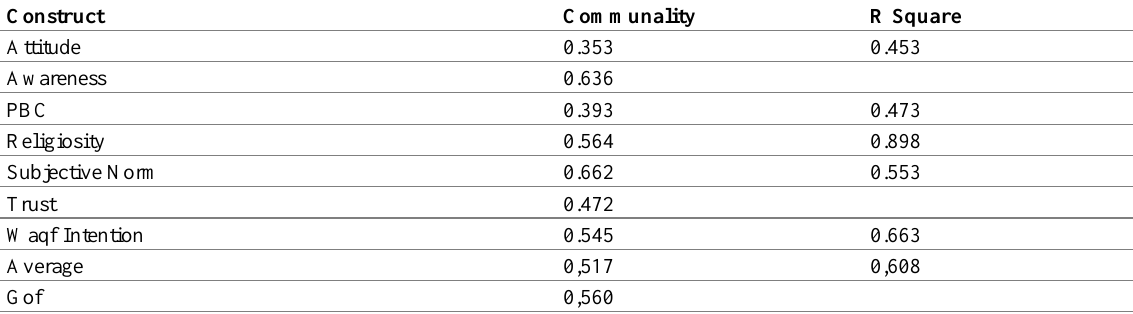
Table 6: Results of Goodness of Fit